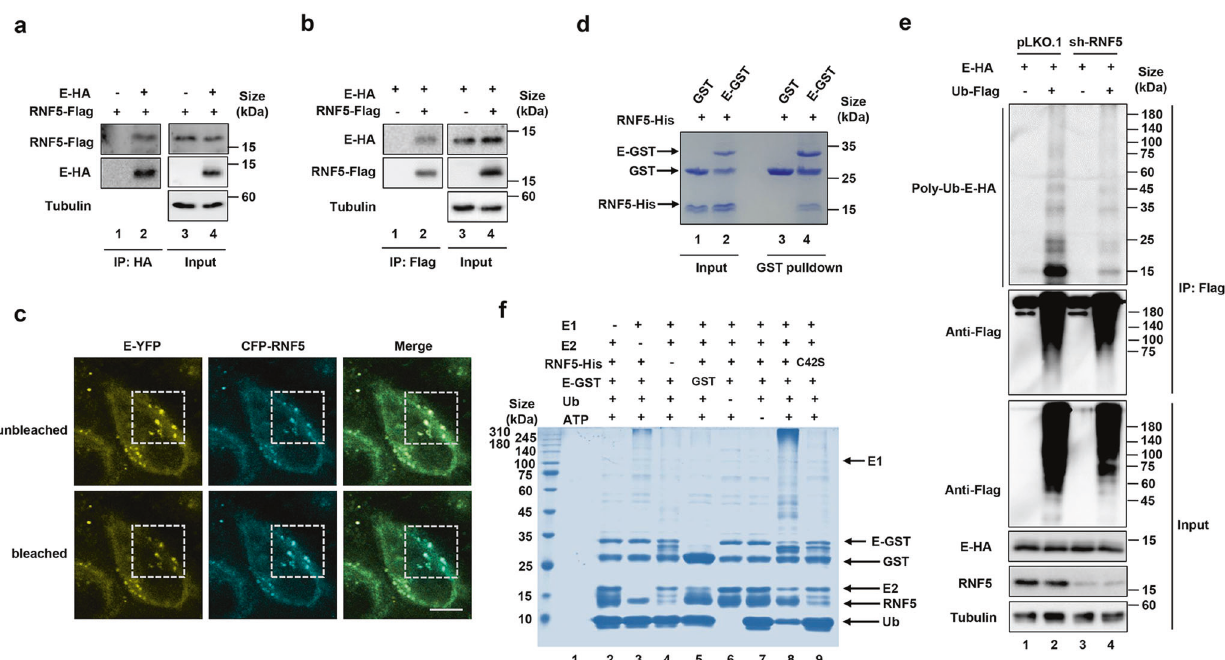
Fig. 2 RNF5 interacts with E. HEK293T cells transfected with constructs expressing E-HA and RNF5-Flag were harvested and lysed. Lysates were subjected to HA antibody IP a or Flag antibody IP b . The precipitates were analyzed by IB with the appropriate antibodies. c Interaction between E and RNF5 determined by FRET analysis. Bars, 10 μ m. d Pulldown of RNF5 by GST-E. Recombinant His6-RNF5 and GST-E were incubated and the potential protein complex was captured with GST Sepharose. e Knockdown of RNF5 decreased ubiquitination of E. Lysates of RNF5-silenced HEK293T cells transfected to express E-HA and ubiquitin-Flag were subjected to HA IP and then analyzed by IB. f Recombinant RNF5 puri fi ed from E. coli catalyzes ubiquitination of E. Dropout reactions with the indicated components were allowed to proceed for 4 h prior to being detected for ubiquitination by Coomassie blue